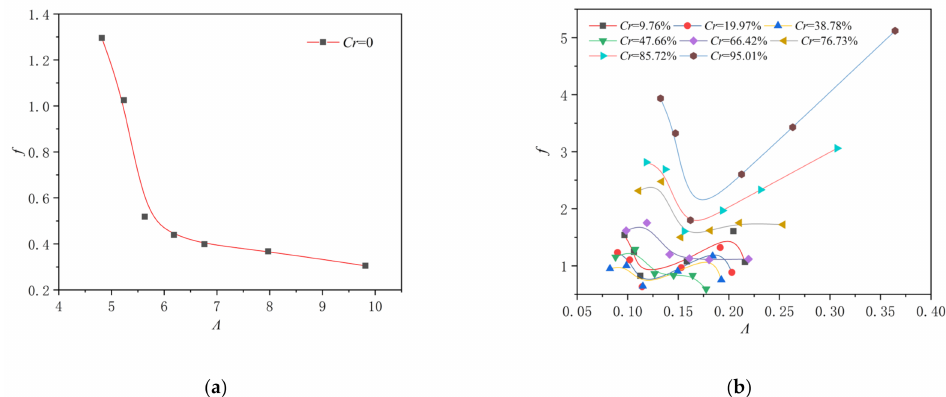
Figure 9. Relationship between resistance coefficient ( f ) and submergence degree ( Λ ): ( a ) without vegetation cover; ( b ) with vegetation